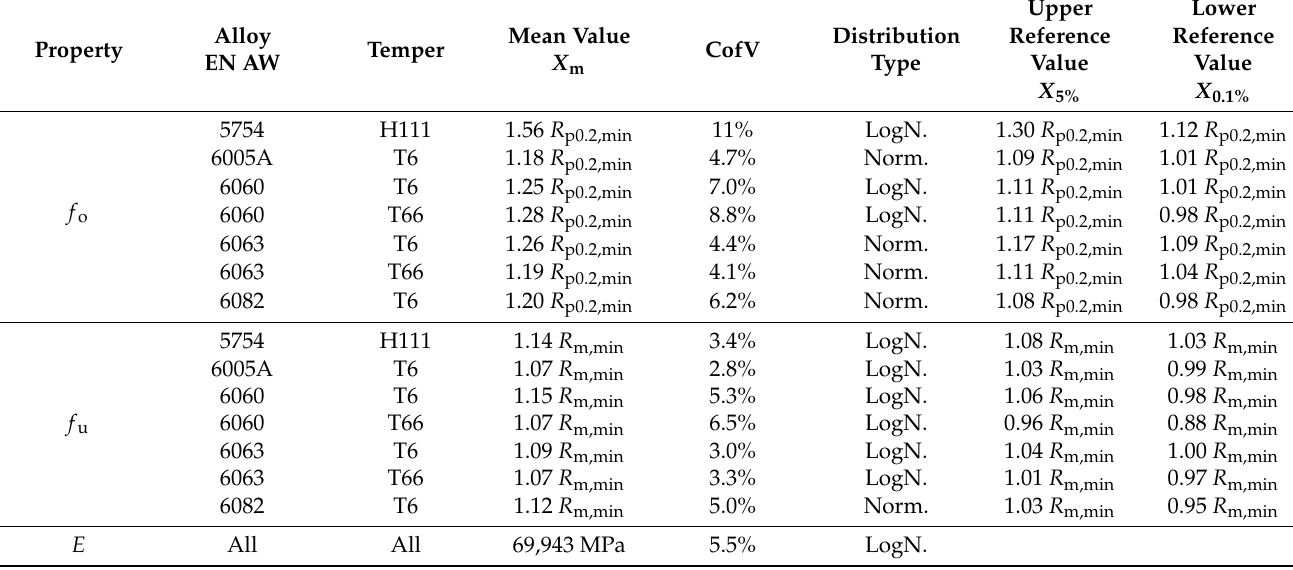
Table 8. Variability of available mechanical